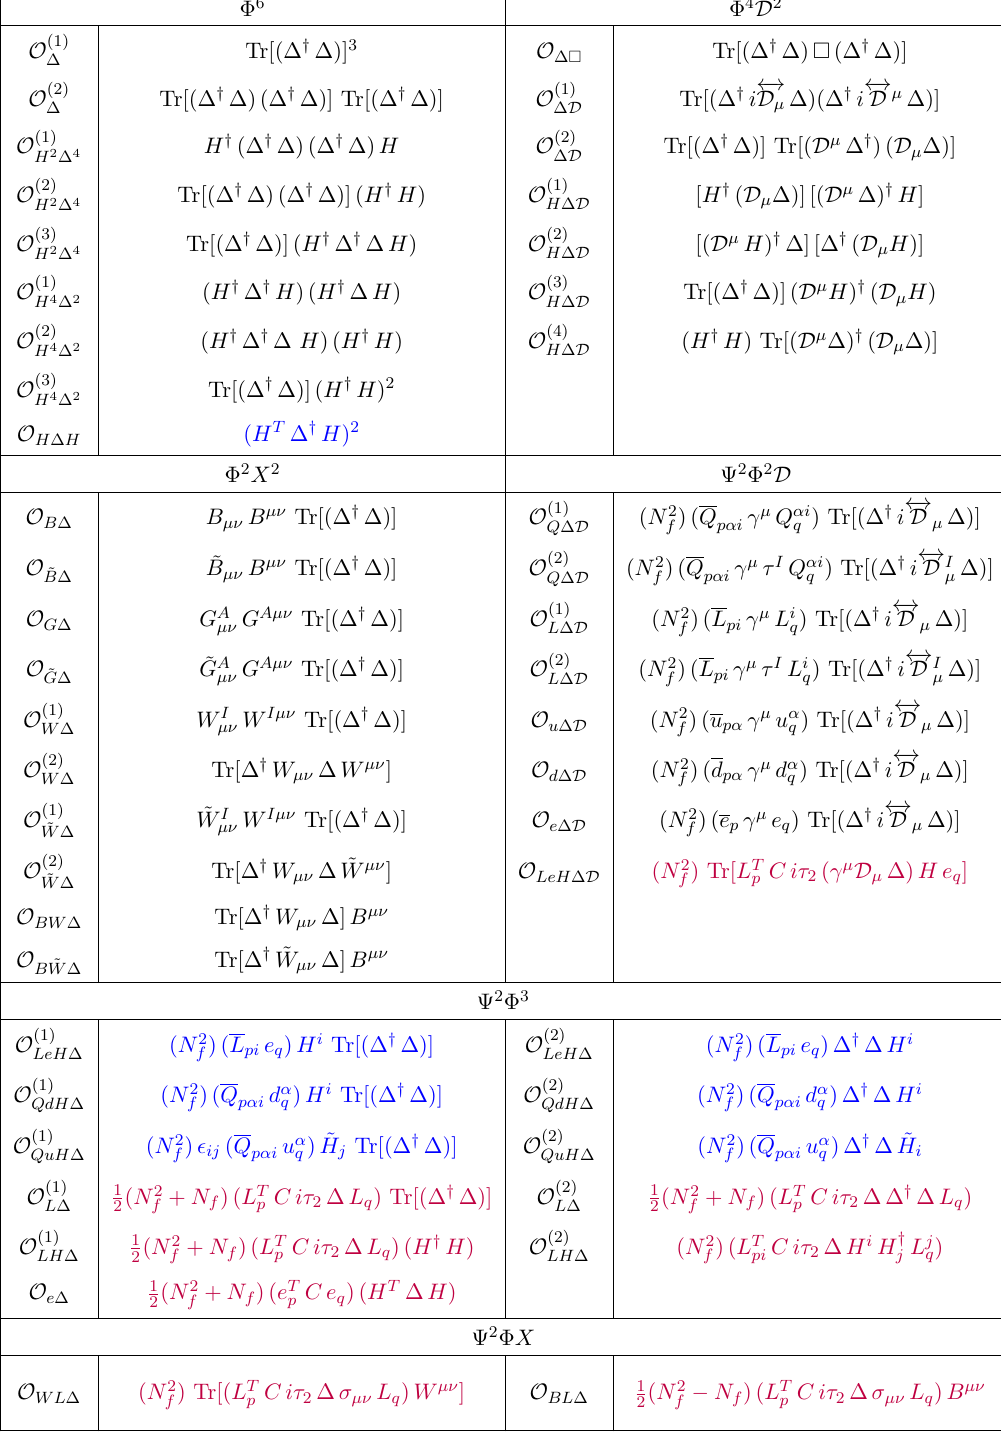
Table 7 . SM extended by Complex Triplet Scalar ( ∆ ): additional operators of dimension 6. Here i, j and α are the SU(2) and SU(3) indices respectively. τ I are the SU(2) generators. A = 1 , 2 , · · · , 8 and I = 1 , 2 , 3 . p, q = 1 , 2 , · · · , N f are the flavour indices. Also, ∆ = ∆ I · τ I and W µν = W I Operators in red violate lepton